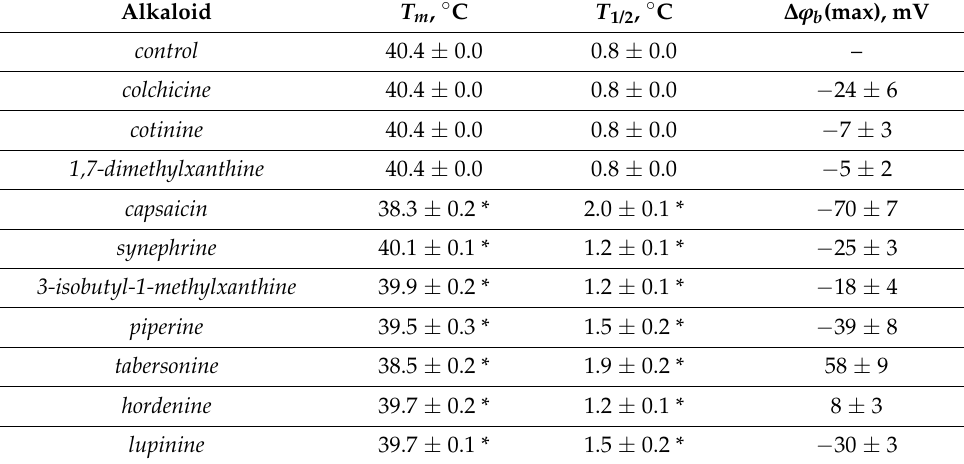
Table 2. The parameters characterized the effects of alkaloids on the physical properties of lipid bilayers: T m —the main transition temperature of DPPG/CHOL (90/10 mol%); T 1/2 —the half-width of the main peak in the presence of 400 µ M of alkaloids (40 µ M of tabersonine); ∆ ϕ b (max)—the maximum changes in the boundary potential of DOPG/CHOL (80/20 mol%)